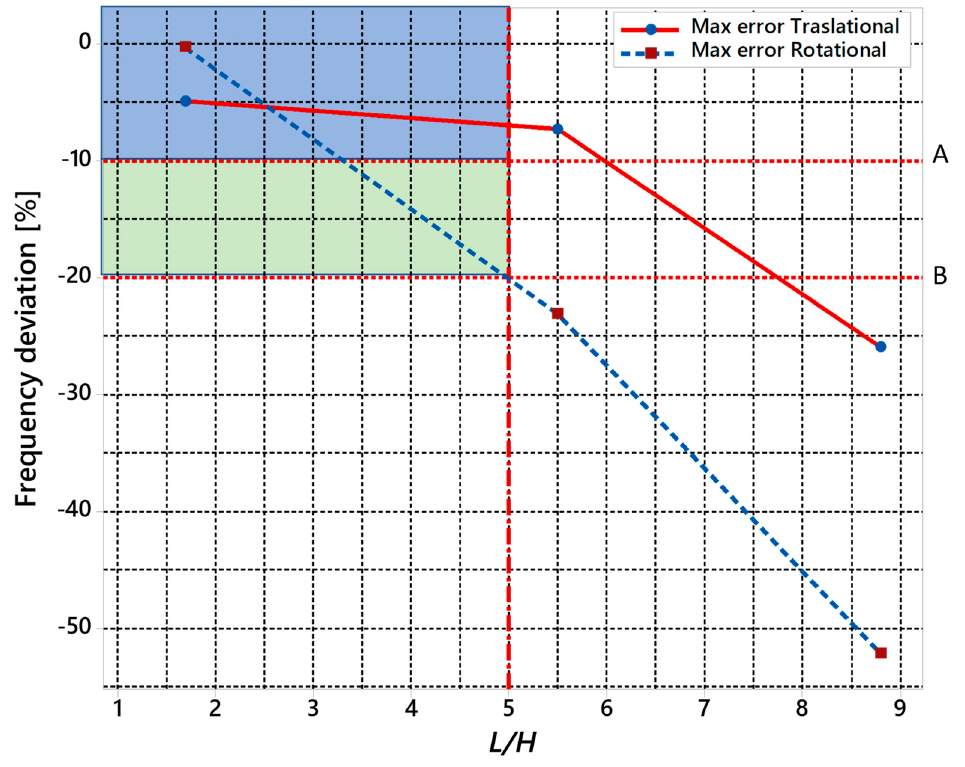
Figure 14. Translational frequency deviation maximum error [%] at different values of L/H .